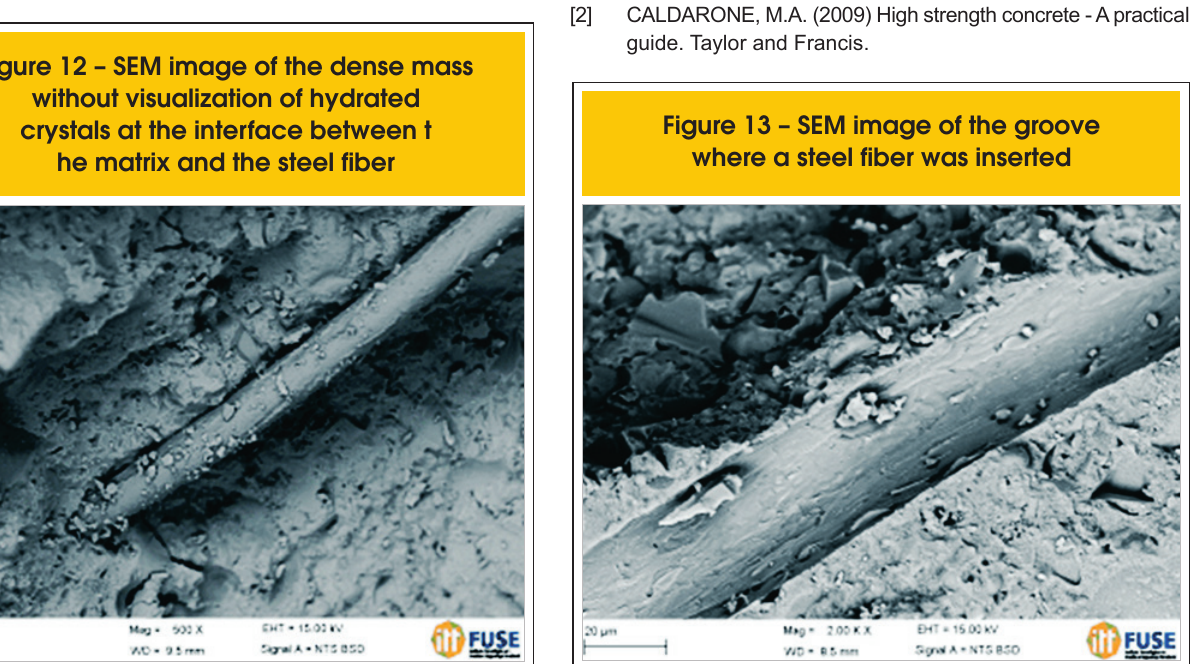
Figure 12 – SEM image of the dense mass without visualization of hydrated crystals at the interface between t he matrix and the steel fiber